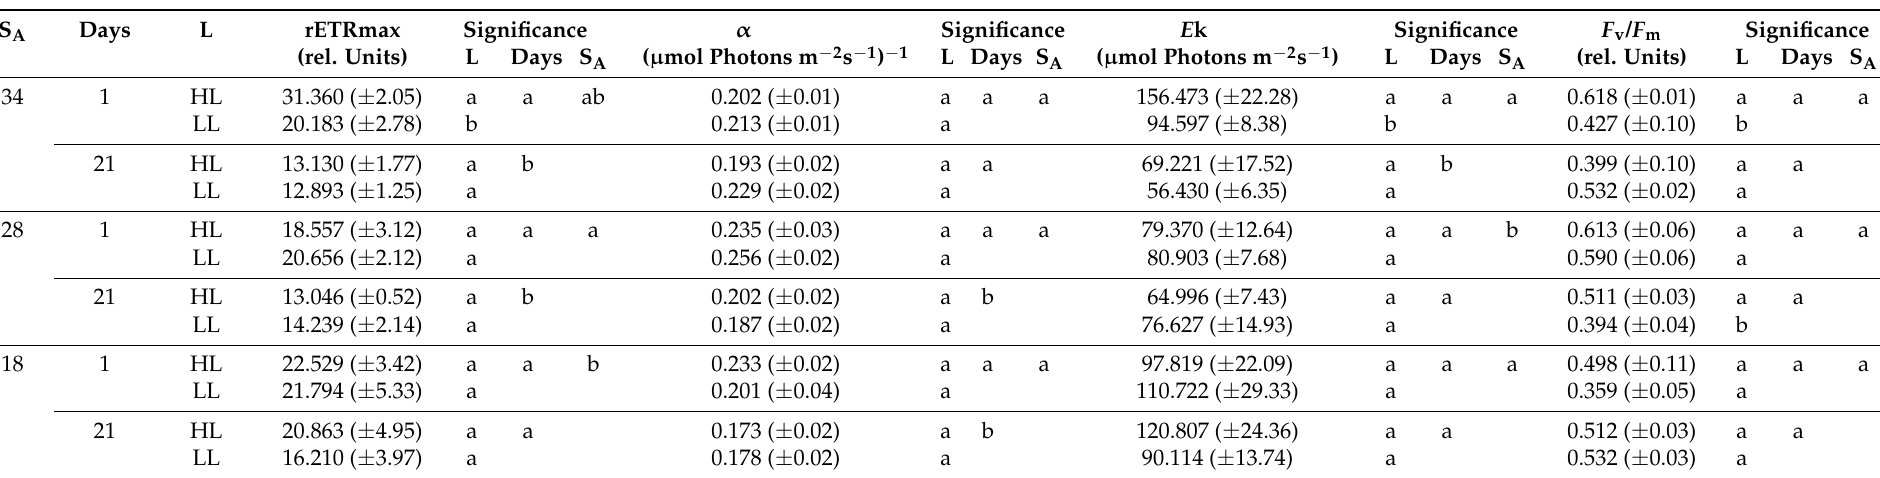
Table 1. Photosynthetic parameters of Desmarestia aculeata : rETRmax, α , E k, and F v / F m . Experimental set-up: salinity (S A )–Light (L) (High Light (HL)–Low Light (LL)) treatments. Values are means ± SD (n = 3). For each parameter (L, Days, S A ), statistically significant differences are marked by different lowercase letters. For all the data, three-way ANOVA with post-hoc Tukey’s test was performed ( p < 0.05).